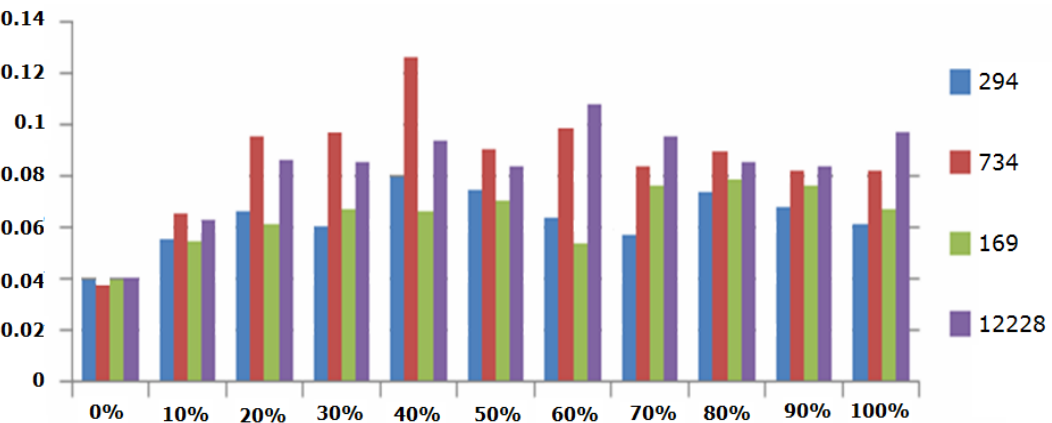
Figure 1. The effect of Chloroprocta sp. ES directly on S. epidermidis 294, 734, and 169 biofilms formation in comparison with ATCC12228 was observed using microtiter plate biofilm assay with or without maggot ES. Measurement performed three times. Horisontal line indicated concentrations of ES, whereas vertical line indicated biofilm OD.